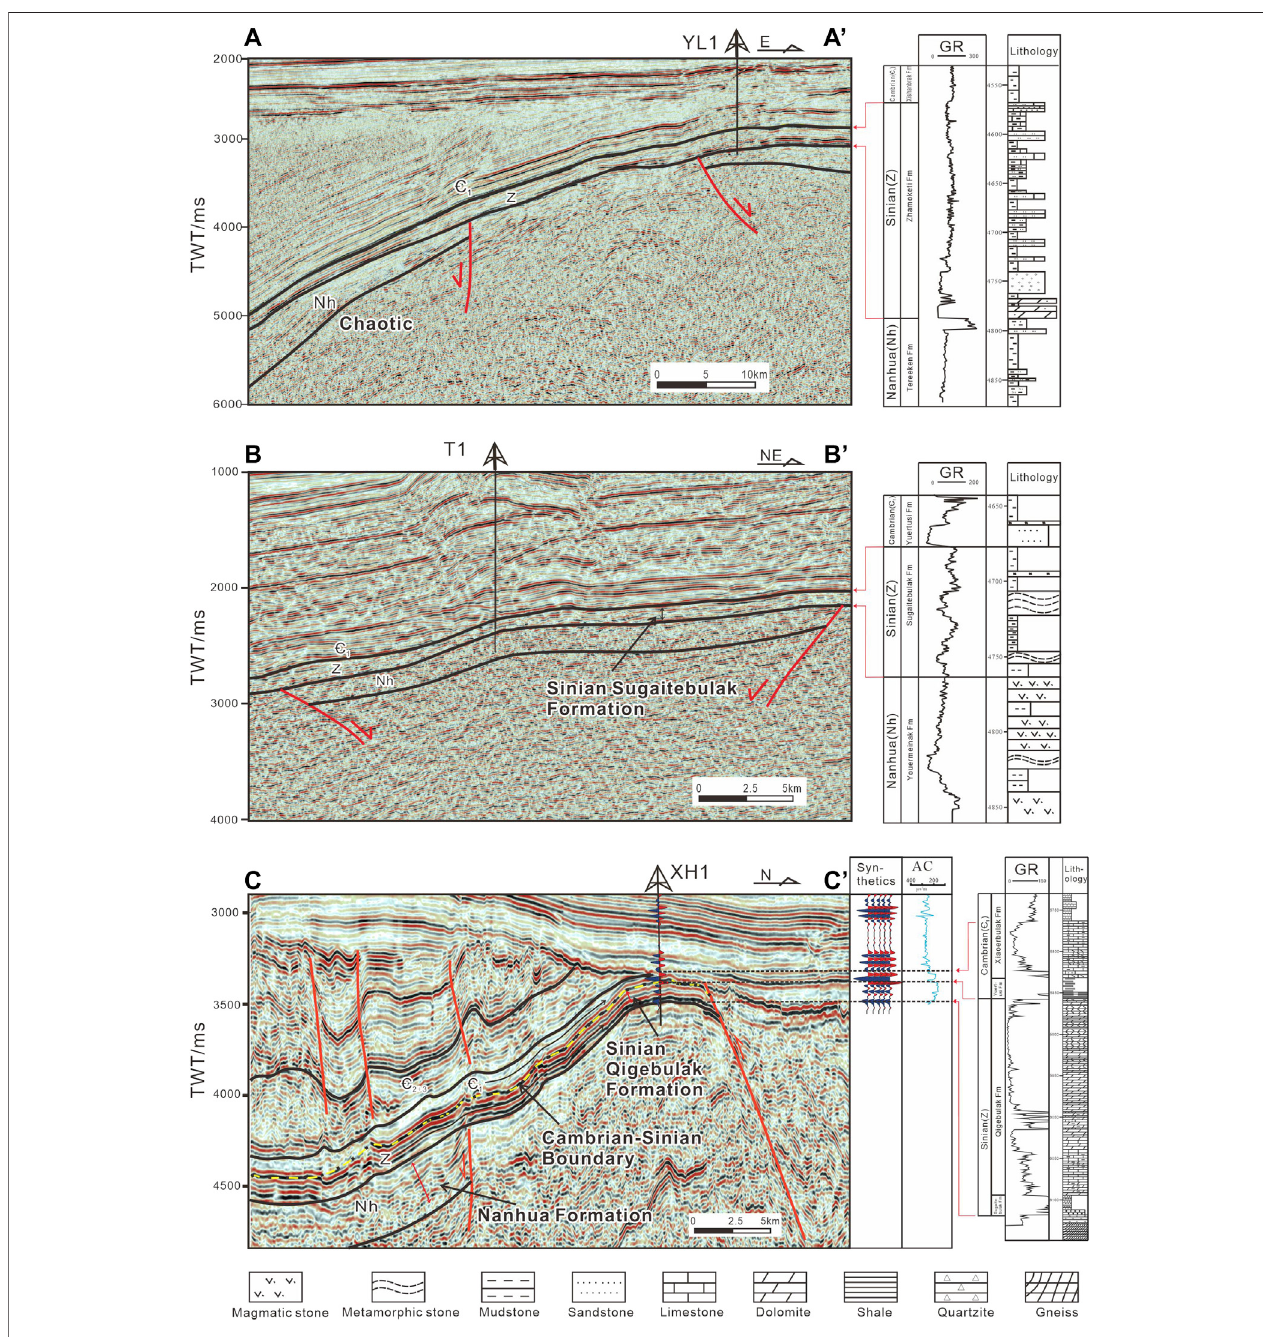
FIGURE 4 | Interpreted seismic pro fi les with the synthetic seismograms of wells YL1, T1, and XH1.